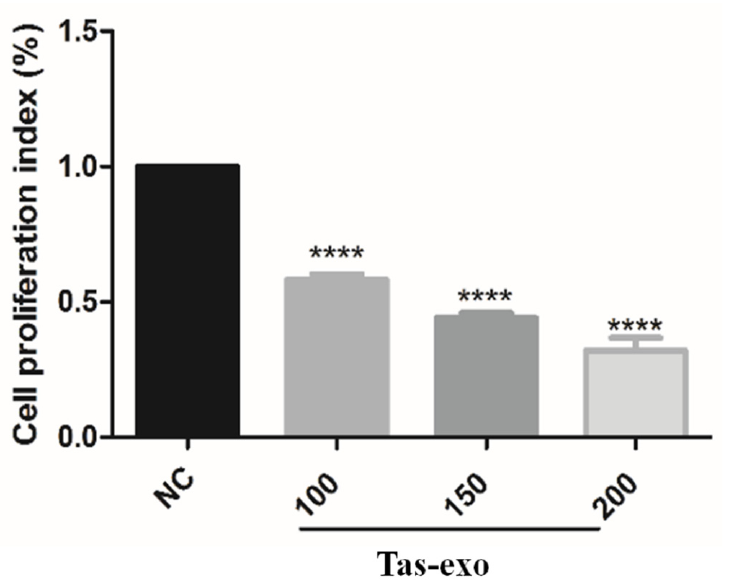
Figure 6. Effect of T. asiatica -derived exosomes at different concentrations on LoVo cell proliferation. Cell proliferation in Tas-exo group and NC group evaluated by CCK-8 assay. Exosome concentrations consisted of 100, 150, and 200 µg/mL, respectively. Data presented as mean ± SEM ( n = 3; **** P < 0.0001).